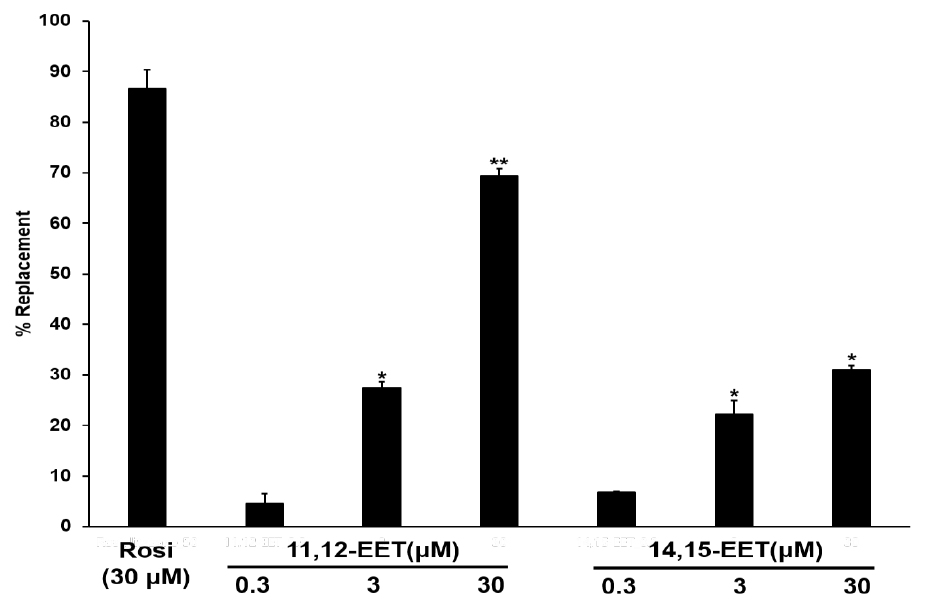
Figure 6. In vitro PPAR γ ligand binding assay for 11,12-EET and 14,15-EET. Displacement of the fluorescent PPAR γ ligand by 11,12-EET and 14,15-EET was analyzed using an in vitro system and detected by a change in the fluorescence intensity. Rosiglitazone (Rosi), a PPAR γ agonist, was used as a positive control. Details are described in the Materials and Methods. All data are presented as the mean ± standard deviation of three independent experiments. * p < 0.05, ** p < 0.01; linear one-way analysis of variance.